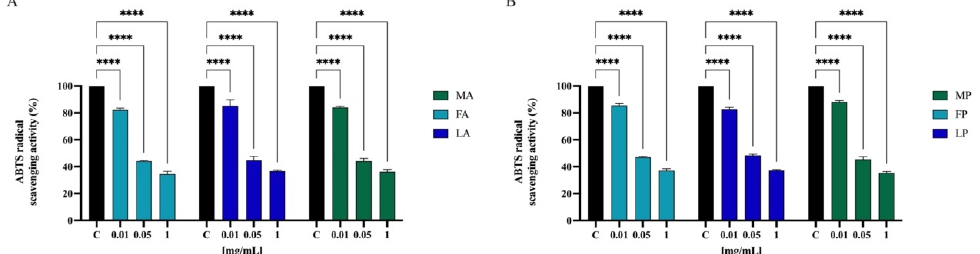
Figure 7. Direct radical scavenging activity of olive seed hydrolysates rom Frantoio (F), Leccino (L), and Moraiolo (M) obtained using alcalase (A) ( A ) and papain (P) ( B ) by ABTS assay. Data represent the mean ± s.d. of six independent experiments, and each experiment was performed in triplicate. All the data sets have been analyzed by two-way ANOVA. (****) p <